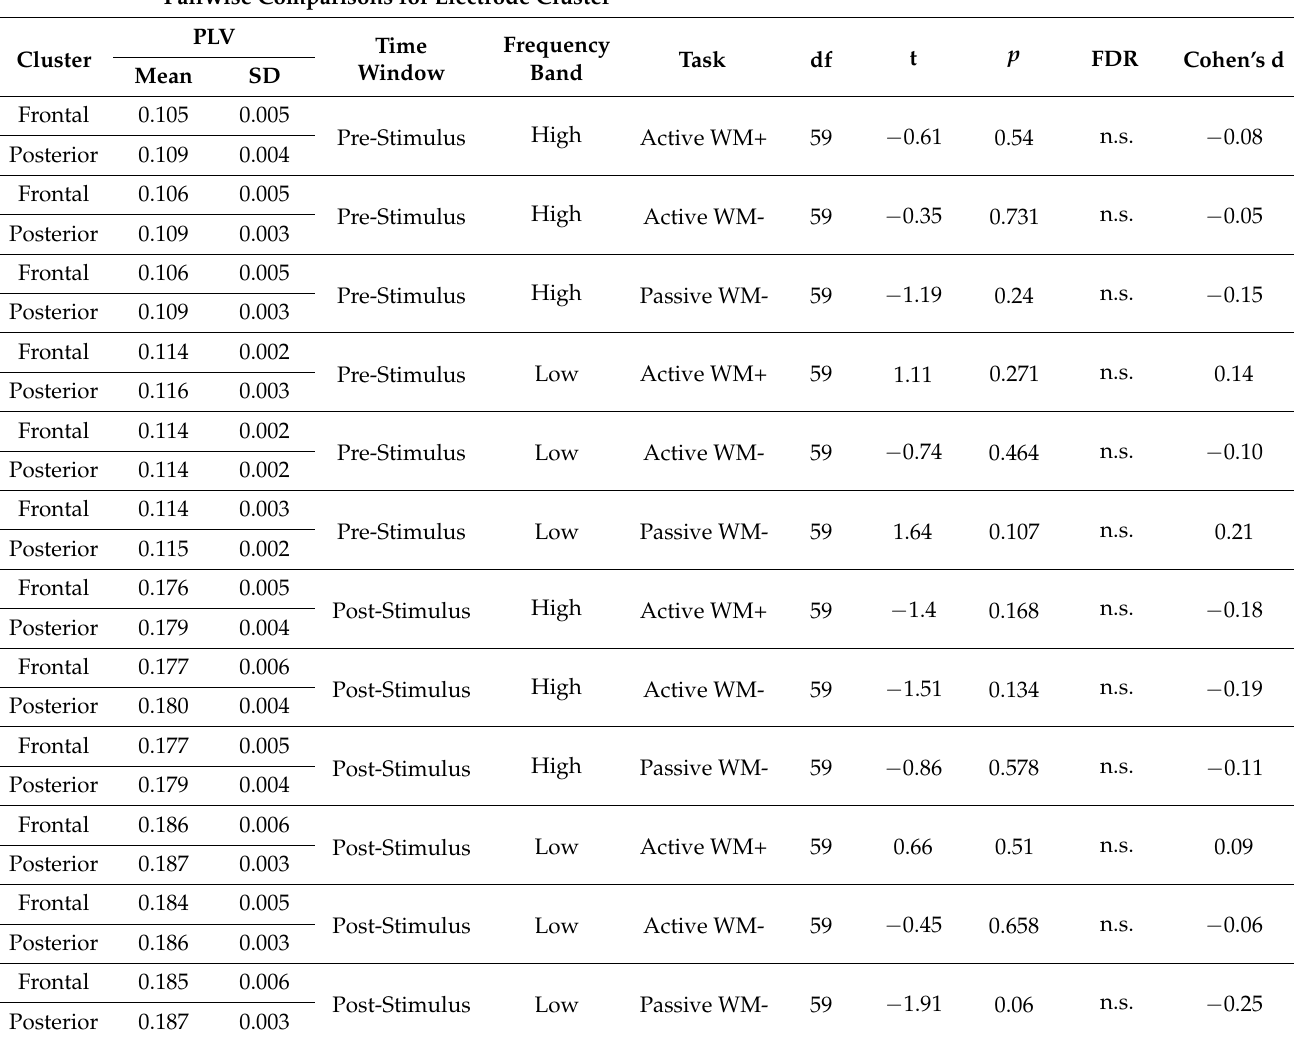
Table 3. A summary of all pairwise comparisons for the two electrode clusters. An FDR correction was applied across comparisons. Significance after the FDR correction is denoted in the corresponding column of the table. When marking